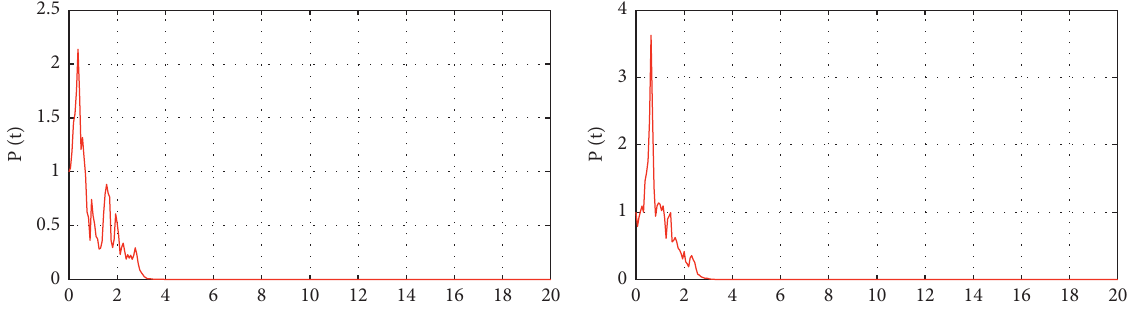
� 1 ,H � 0 . 8. (a) θ � 1 , u � 1 ,v � 1. (b) θ � − 1 , u � 1 ,v � 1. The trajectories of system (91) 0